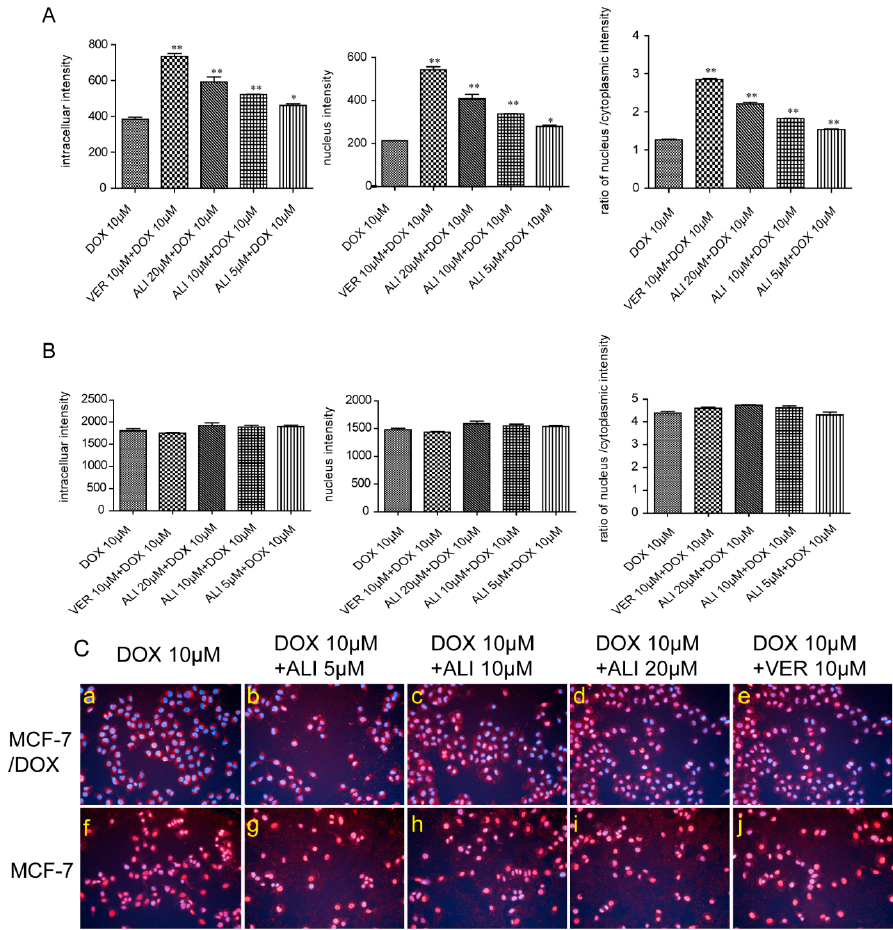
Figure 7. Influence of ALI on the accumulation and nucleus distribution of DOX in MCF-7/DOX cells and MCF-7 cells. ( A ) Influence of ALI on the accumulation and nucleus distribution of DOX in MCF-7/DOX cells; ( B ) Influence of ALI on the accumulation and nucleus distribution of DOX in MCF-7 cells. Data are presented as means ± SEM of triplicate determinations. Significance levels * p < 0.05; ** p < 0.01; ( C ) Influence of ALI on the nucleus distribution of DOX in MCF-7/DOX cells (( a ) DOX 10